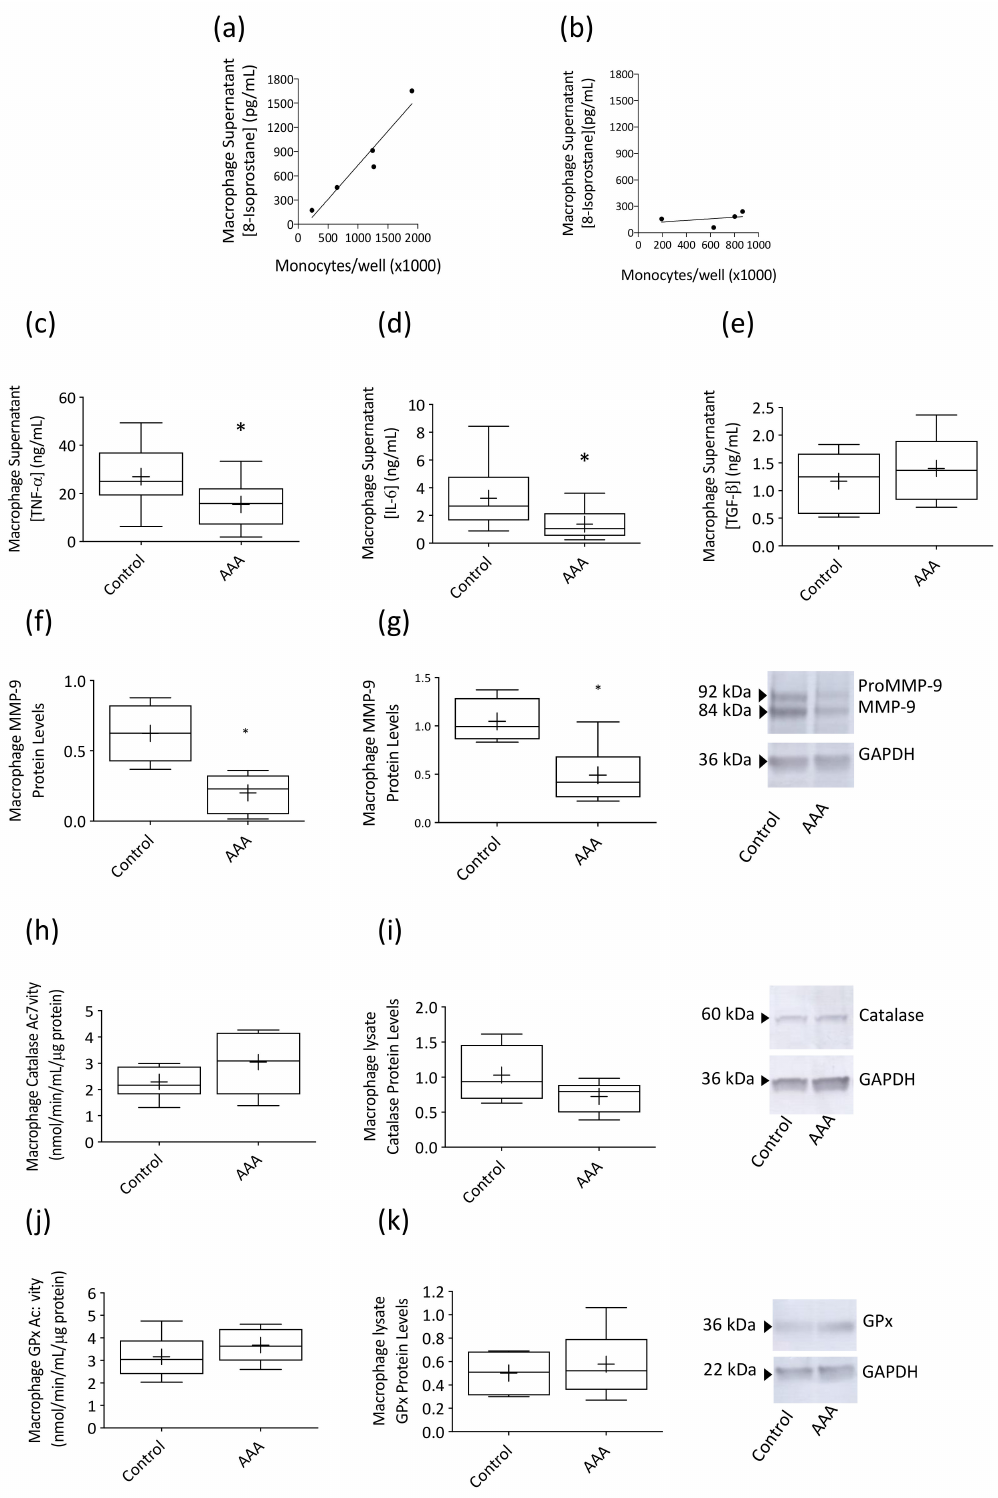
Figure 2. Cytokine, 8-isoprostane and antioxidant enzyme activity levels in supernatants and lysates obtained from AAA patient and control subject monocyte-derived macrophages.